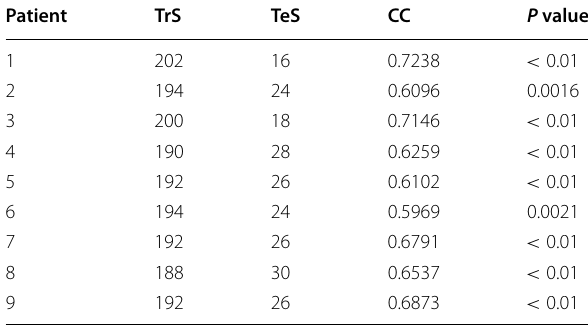
Table 3 Result about the effectiveness evaluation of quantitative model